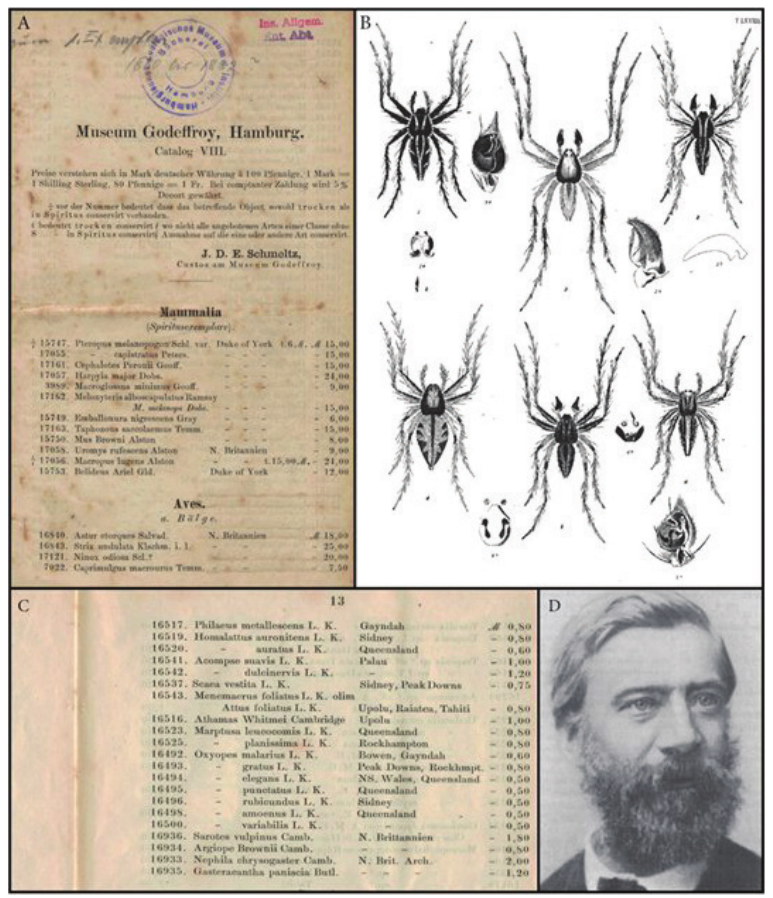
Figure 2. Historic images: A, Front page of the Godeffroy sales catalogue No. 9; B, Original illustrations for oxyopids taken from L. Koch’s monumental work “Die Arachniden Australiens”, C, Detailed view of the sales catalogue that offers oxyopid spiders for sale (left column = Godeffroy registration numbers, right column = price per specimen); D, Eduart Dämel, the main collector of the historic